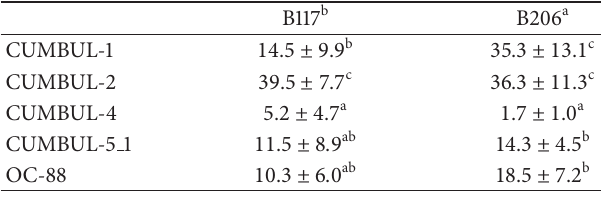
Table 5: Number of emerged Orobanche cumana shoots per sunflower plant (mean ± standard deviation) in the evaluation